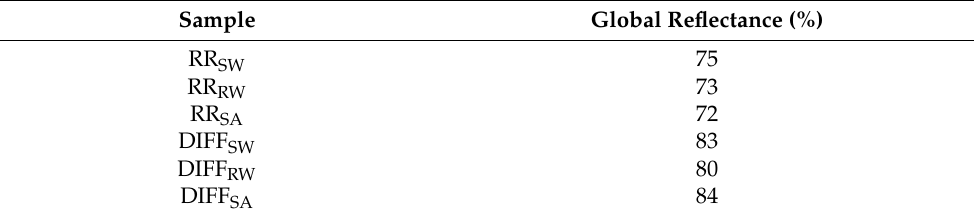
Figure 4. Spectral reflectance of samples. Table 2. Global reflectance of samples.